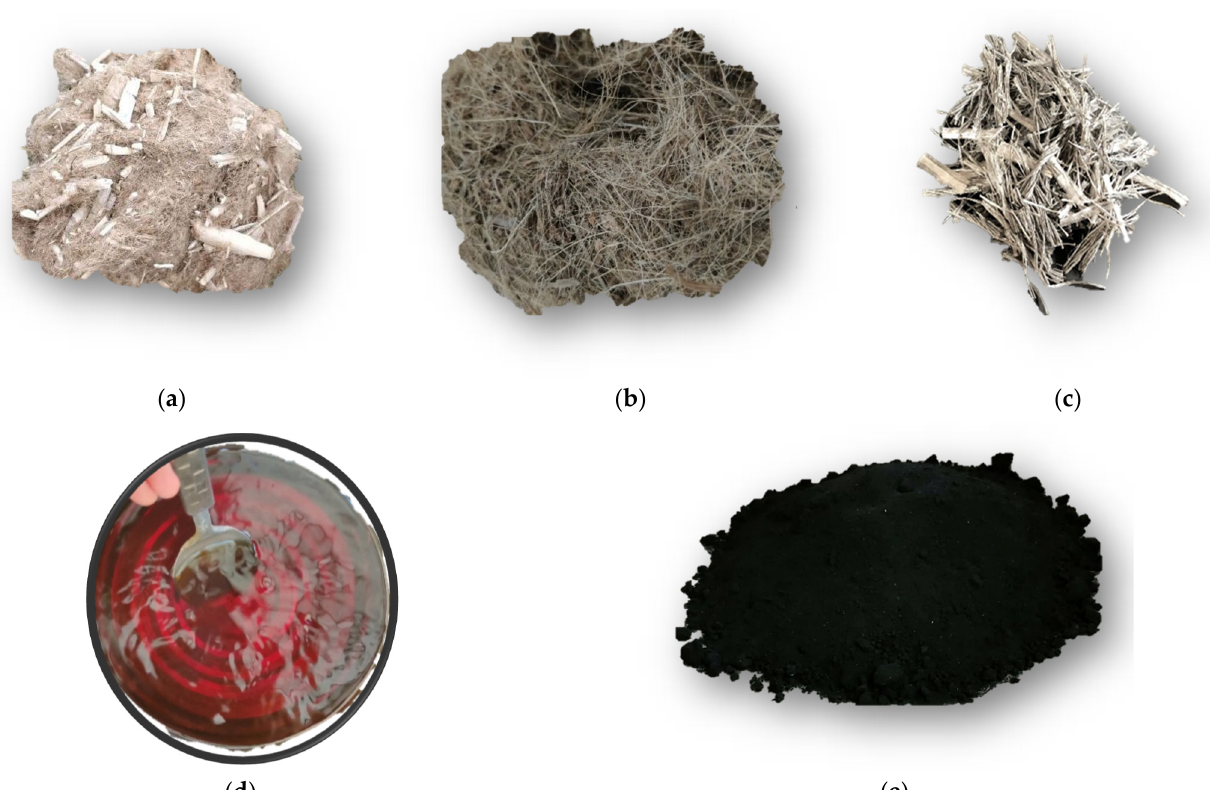
Figure 1. Grading curves for sand and crumb rubber aggregates.